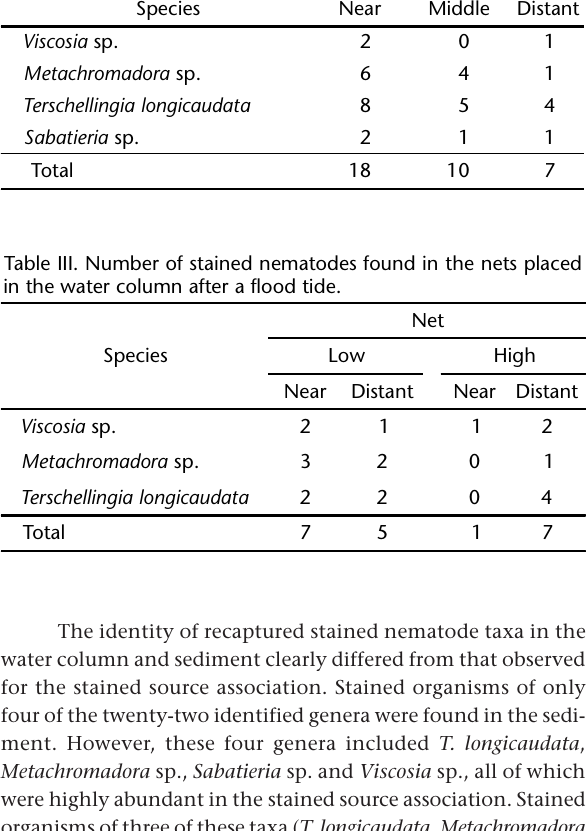
Table II. Number of stained nematodes captured in the sediment of the three zones (near = 0-0.5 m, middle = 0.5-1.0 m and distant = 1.0-2.0 m) after a flood tide. Species Near Middle Distant Viscosia sp. Metachromadora sp. Sabatieria sp.